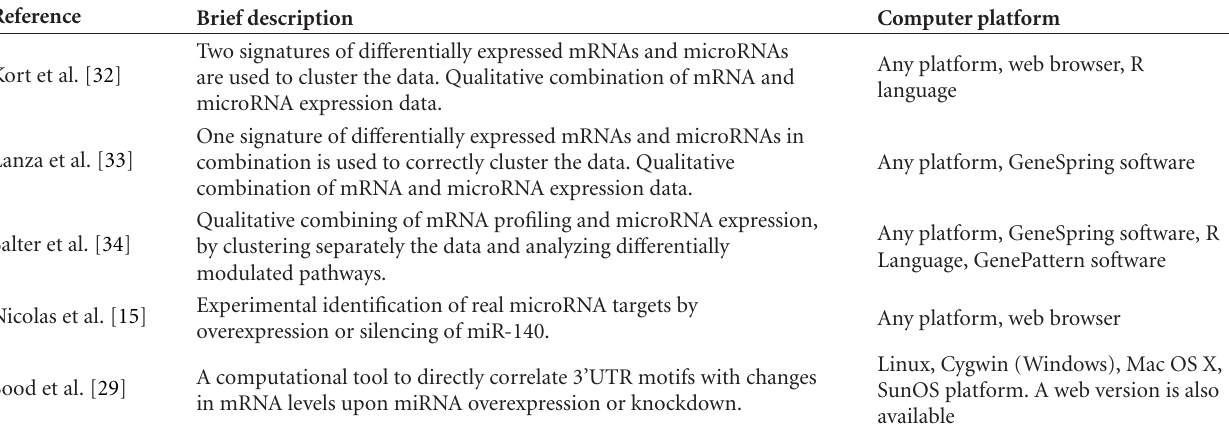
Table 3: Other computational and experimental approaches capable of performing more reliable analysis by combining miRNA and mRNA expression